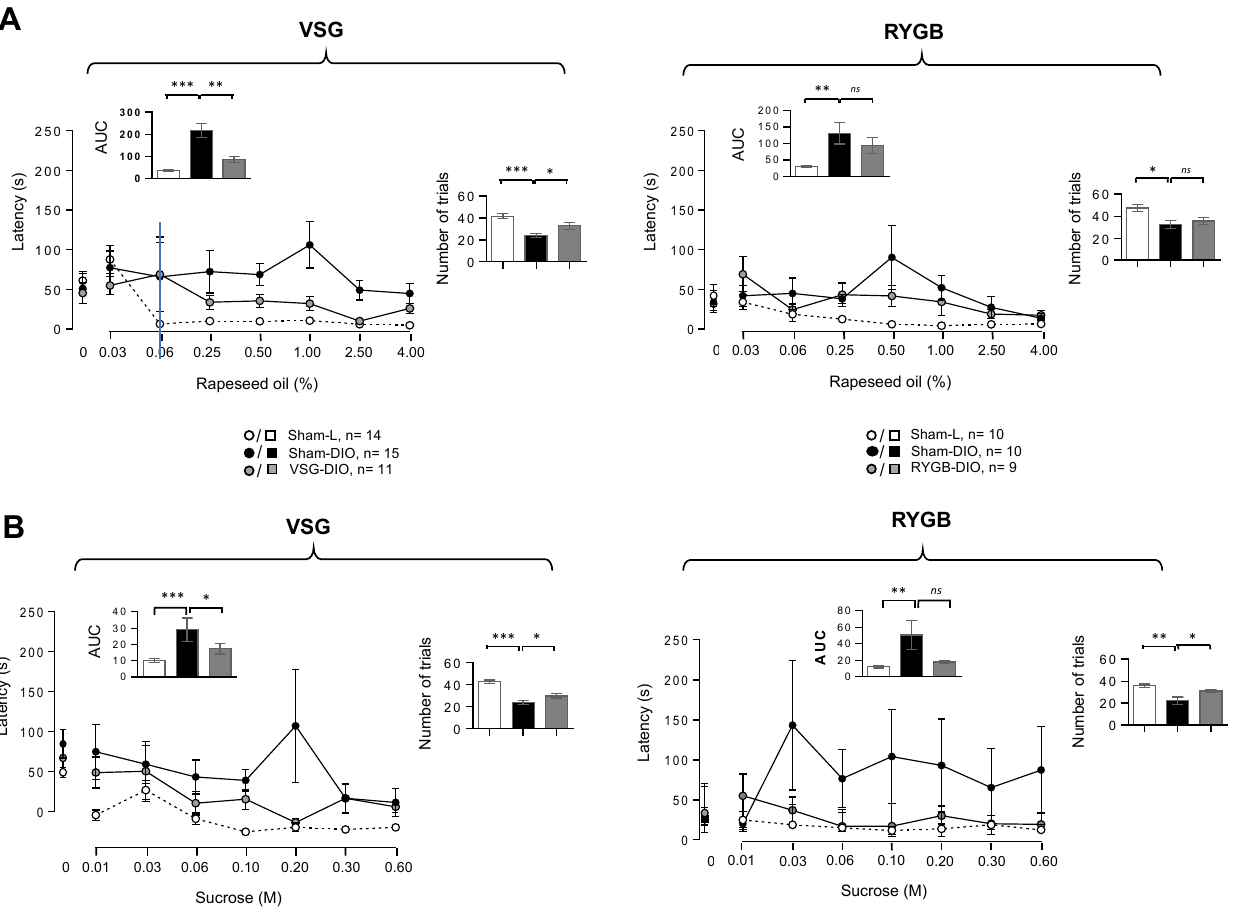
Figure 4. Motivational components of the taste-driven responses to oily emulsion and sucrose solution in sham-operated lean (Sham-L) and obese (Sham-DIO) controls and in obese mice that underwent a vertical sleeve gastrectomy (VSG-DIO) or a Roux-en-Y gastric bypass (RYGB-DIO). Latency is the time between the presentation of a bottle and the initiation of the first lick and the number of trials is the number of solutions licked during the 30 min taste-testing session. ( A ) Oily solutions. ( B ) Sucrose solutions. Zero on the X-axis represents the licking rate in response to the control solution without oil or sucrose. Analysis of both areas under curves (AUC, Inserts) and a number of trials during the 30 min of taste-testing sessions was performed using the Sham-DIO group as reference. Mean ± SEM. ns— non-significant, * p < 0.05, ** p < 0.01, *** p < 0.001. DIO—diet-induced obesity.